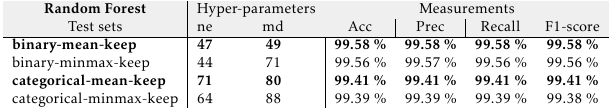
Table 6. Best binary and categorical classifiers modelled with Random Forest Algorithm; ne and md correspond to number of estimators and maximum